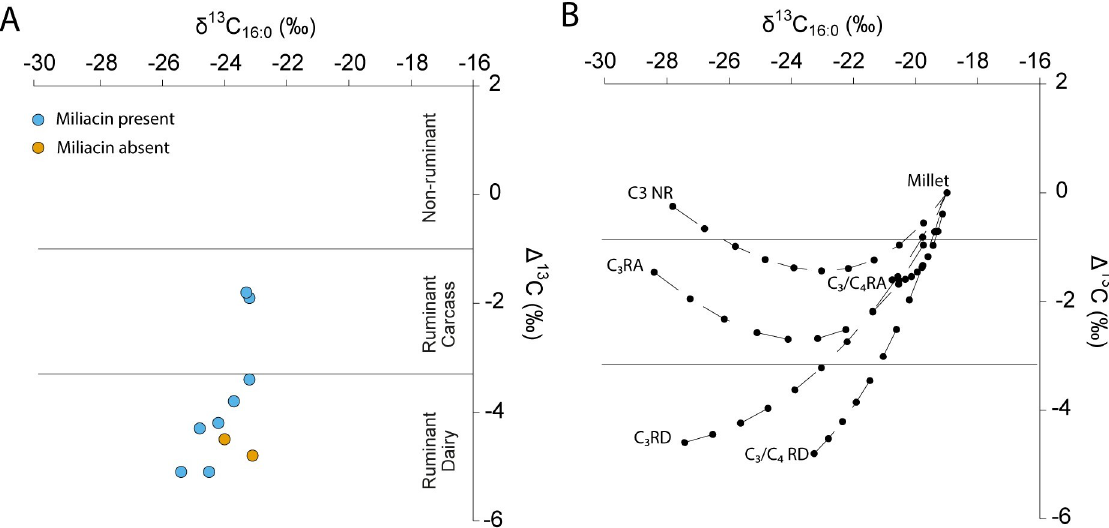
Fig 12. Compound specific stable carbon isotopic data from Siwa potsherds compared with reference fats and oils and illustration of potential mixtures. In each plot the δ 13 C 16:0 values are plotted against Δ 13 C ( δ 13 C 18:0 - δ 13 C 16:0 ) to distinguish the different sources of fats. A. Fatty acids carbon stable isotope values plotted against reference ranges. The ranges represent the mean ± 1 s.d. of the Δ 13 C values for a global database comprising modern reference animal fats raised on a variety of C-3 and mixed C3/C4 diets [69] B. Shows average isotopic endpoints for non-ruminant (NR), ruminant adipose (RA), and ruminant dairy (RD) fats with C 3 and mixed C 3 /C 4 diets and millet obtained from measurements of authentic modern products corrected for post-industrial carbon (S1 File, Table 2). Hypothetical mixing lines in 10% increments are shown between each endpoint and millet calculated from the mean relative amount of each fatty acids in each product using data obtained from the USDA database.